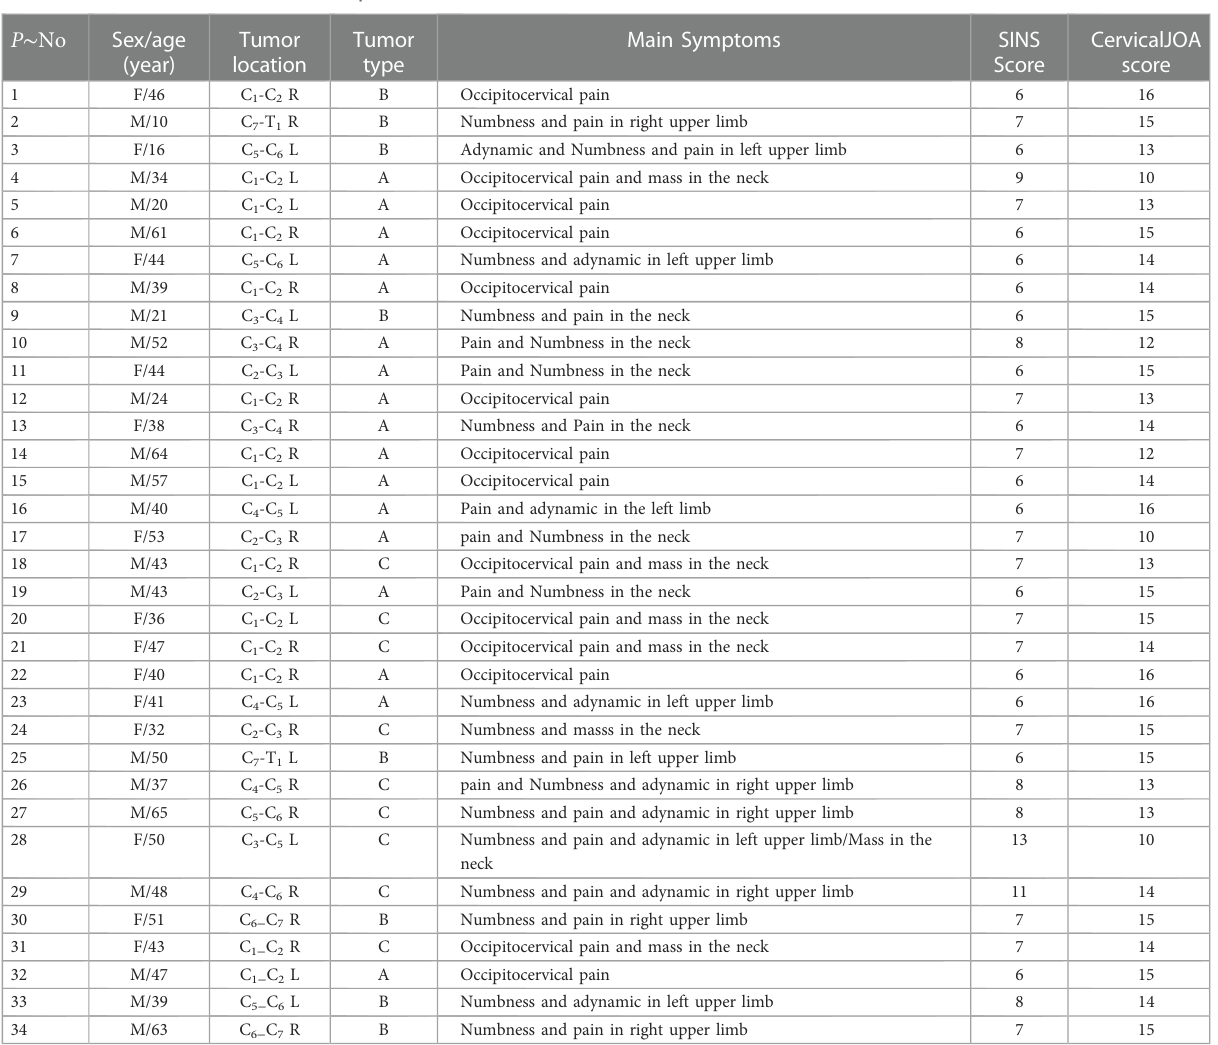
TABLE 1 The clinical manifestations of the